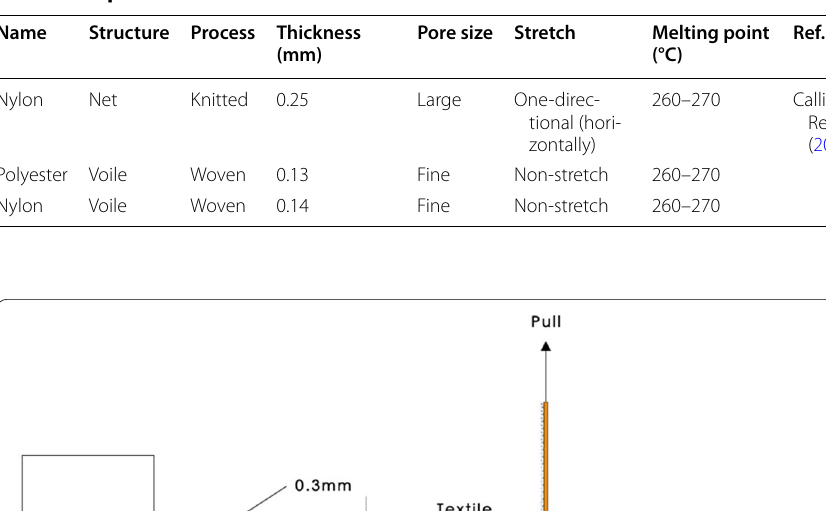
Table 6 Properties of the three textile substrates (mesh fabrics) used for the ME polymer– textile composites